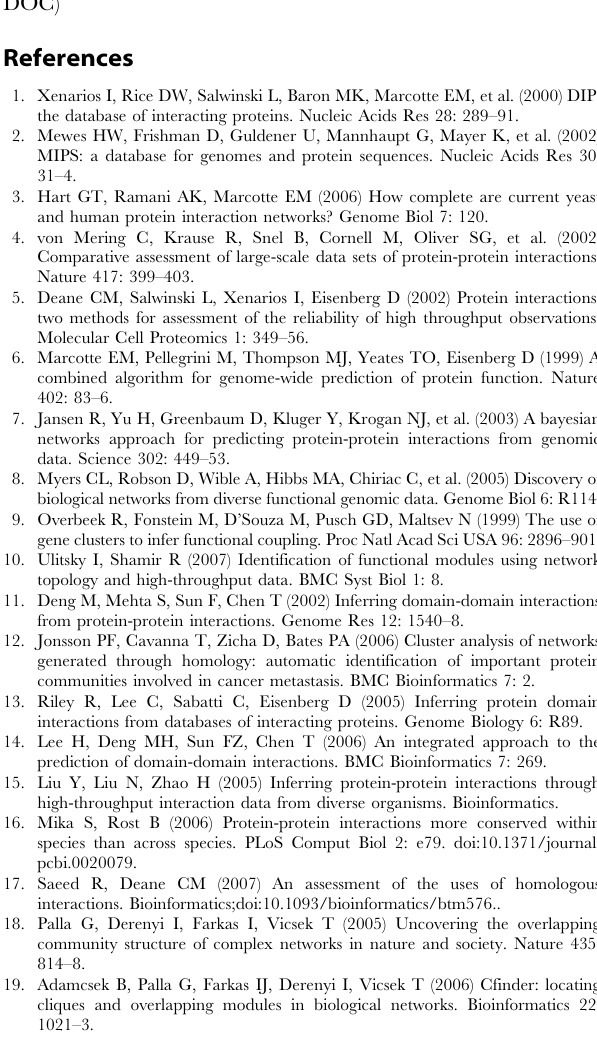
Table S2 Observed patterns vs. all possible patterns {